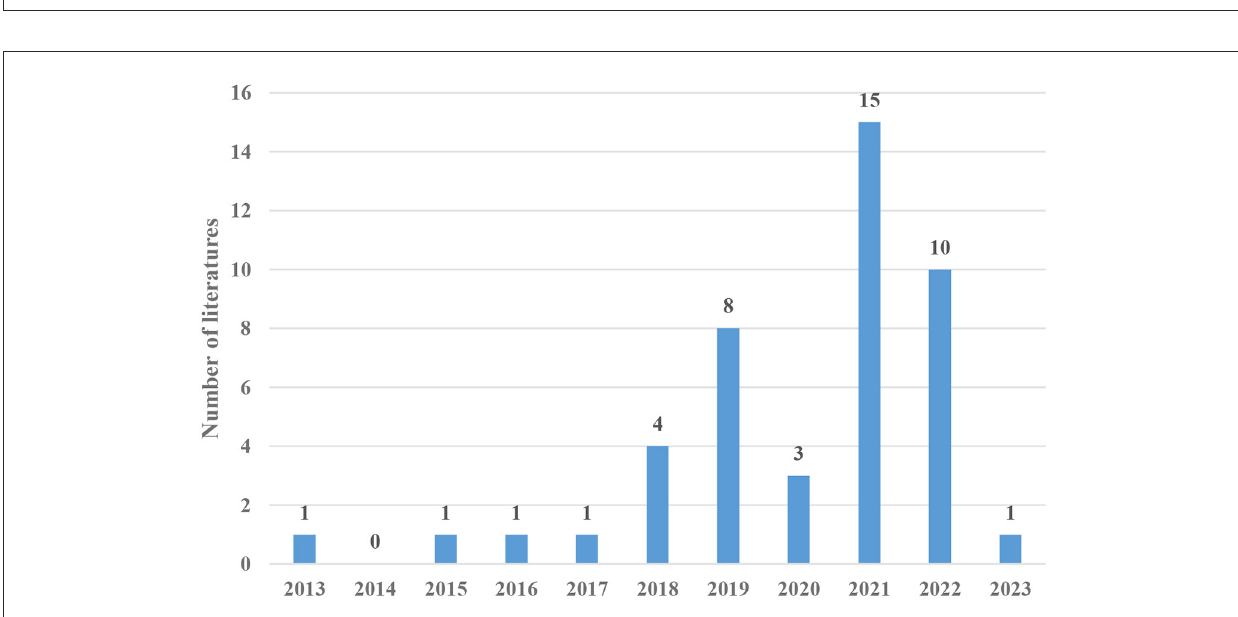
FIGURE2 Number of selected publications in the last